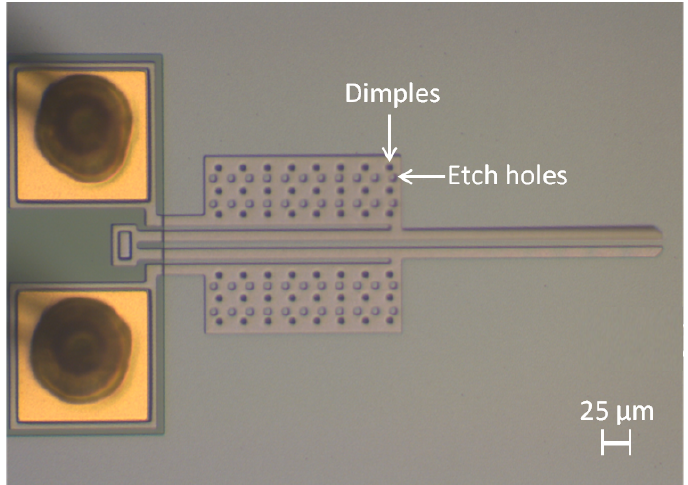
Figure 3. Optical microscope image of the fabricated polysilicon microgripper, also showing the gold wire bond interconnections on the probe pads for electrical activation of the